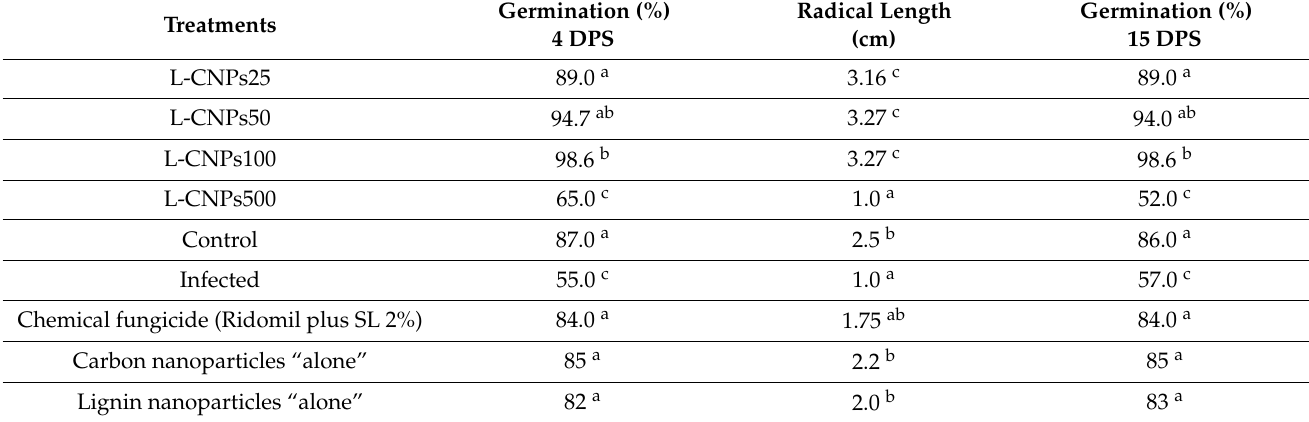
Table 1. Effects of the treatments with different concentrations of L-CNPs on maize seed germination and radicle length (L-CNPs25, L-CNPs50, L-CNPs100, and L-CNPs500 and applied to seed for priming). The germination was recorded at 4 and 15 days after the treatments, while the radicle length was recorded at 5